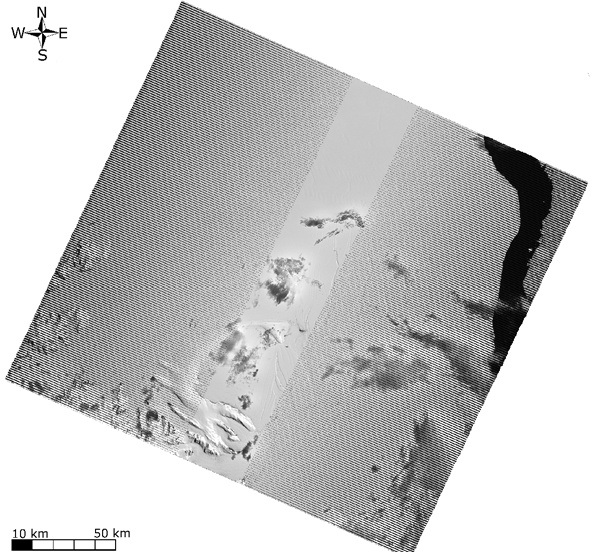
Fig. 2. Landsat 7 ETM+ pan image from 2006 path 216 row 108 used in this study that shows the regular cross-track data voids caused by the failure of the Scan Line Corrector.